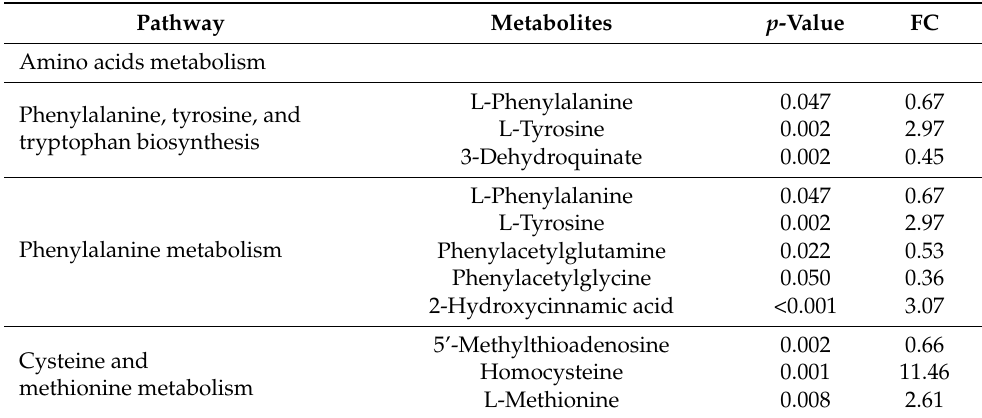
Table 3. The altered metabolic pathways and the corresponding differential metabolites in AF samples from CON and GDM